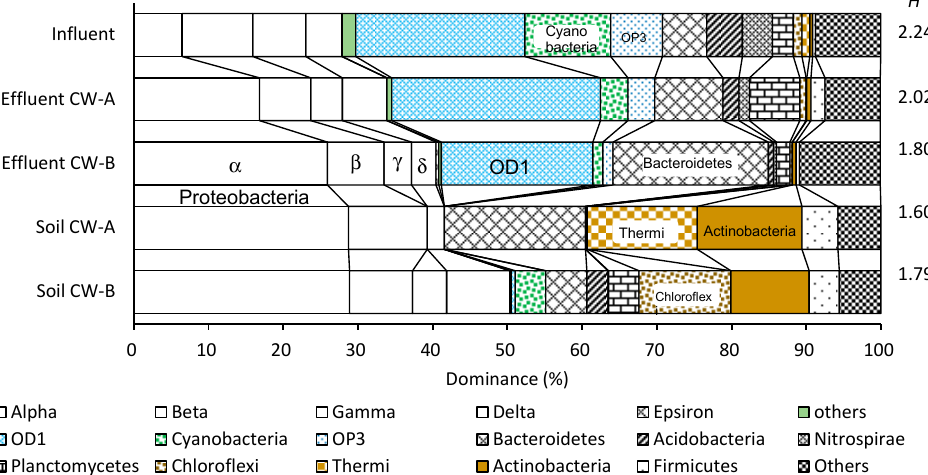
Figure 7. Bacteria community compositions at the phylum level in water and soil samples of the unplanted CW (CW-A) and the cattail-planted CW (CW-B) treating the NMD.